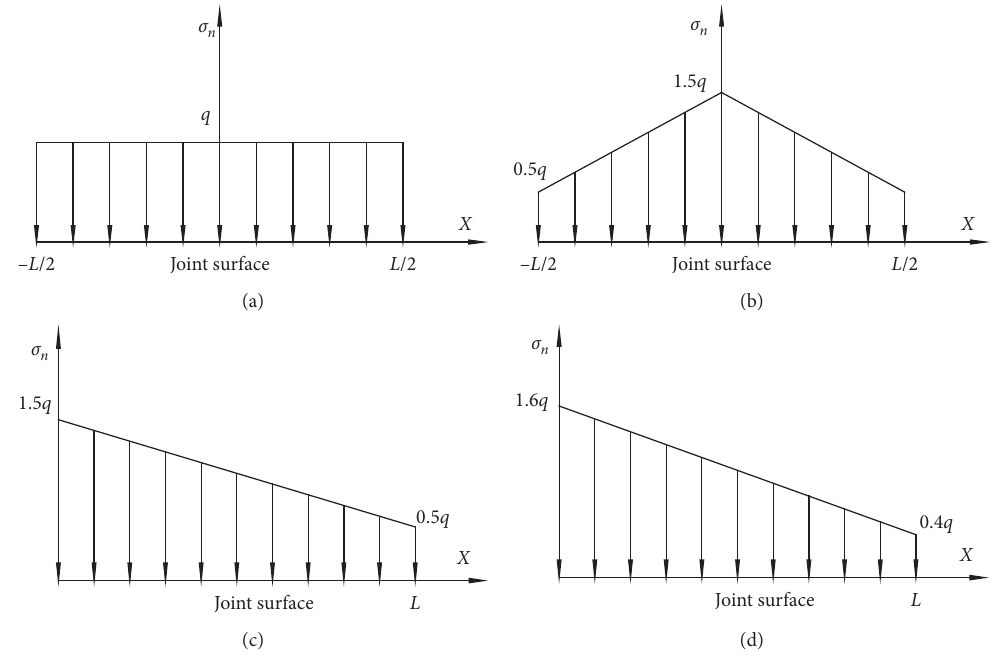
Figure 4: Distribution patterns of normal stress along the joint surface (where q � 1.0 Mpa). (a) Uniform distribution. (b) Symmetric distribution. (c) Linear distribution. (d) Linear